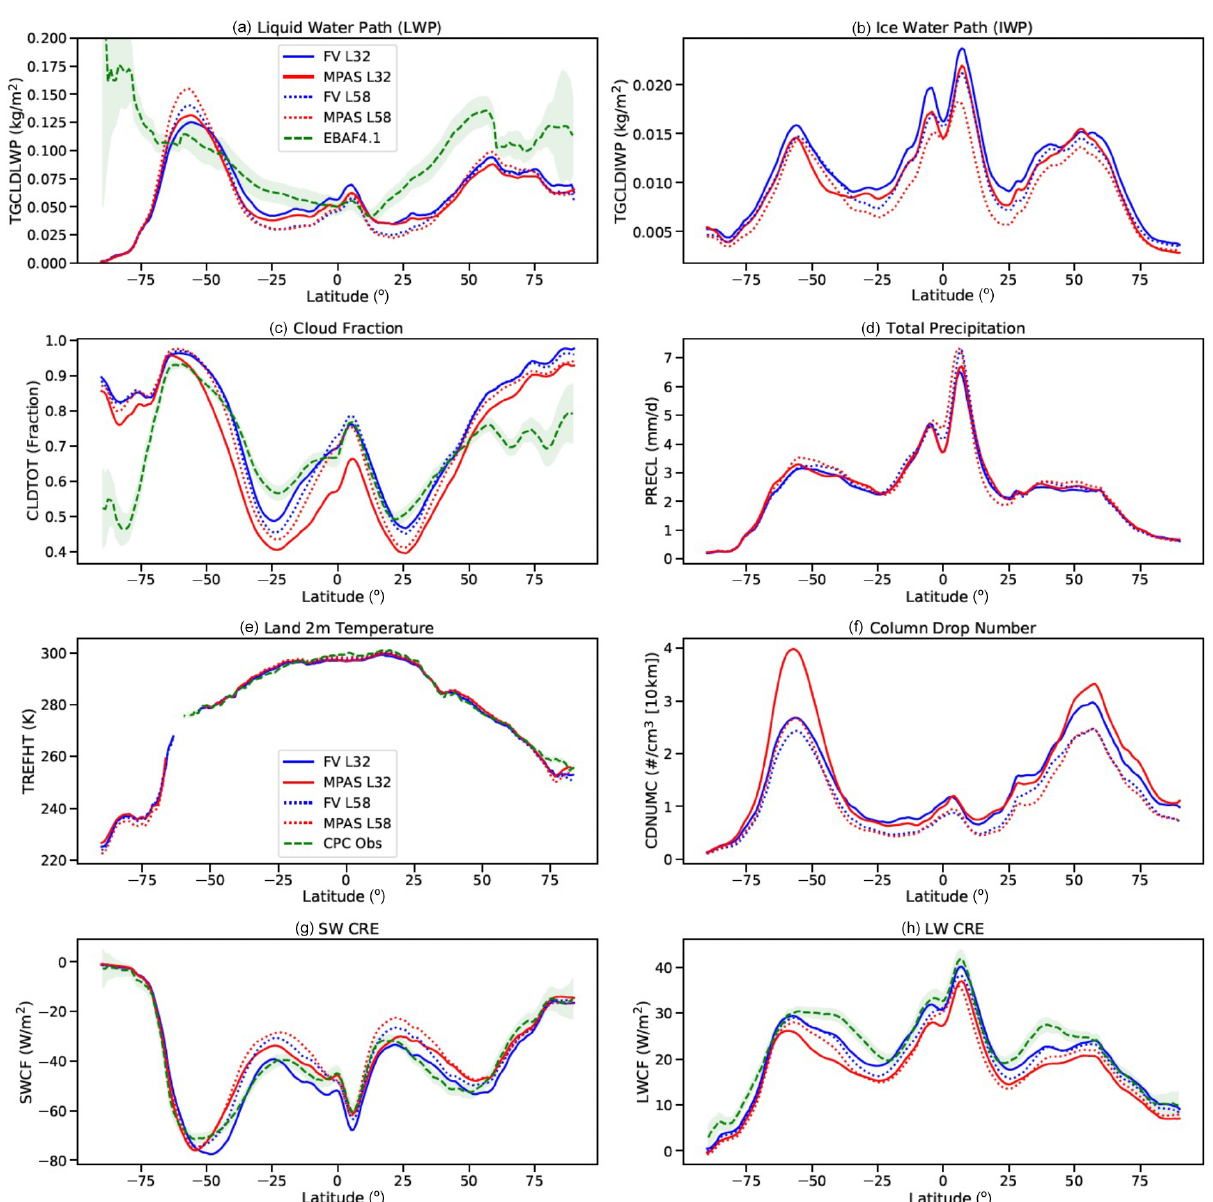
Figure 3. Zonal mean climatology from 5-year simulations with CESM2 and CAM6 physics using different dynamical cores and vertical levels: (a) liquid water path (LWP), (b) ice water path (IWP), (c) cloud fraction, (d) total precipitation rate, (e) land 2m air temperature, (f) column drop number, (g) shortwave (SW) cloud radiative effect (CRE), and (h) longwave (LW) CRE. Simulations are the default finite- volume (FV) dynamical core with 32 levels (FV L32: solid blue) and 58 levels (FV L58: dashed blue). Also shown are the MPAS dynamical core with 32 levels (MPAS L32: solid red) and 58 levels (MPAS L58). Observations are shown in green for CERES 20-year climatology (from 2000–2020) for LWP, cloud fraction, SW CRE, and LW CRE and for GHCN_CAMS Gridded 2m Temperature (Land) from 1990– 2010 for (e) . Shaded values are 1 σ annual standard